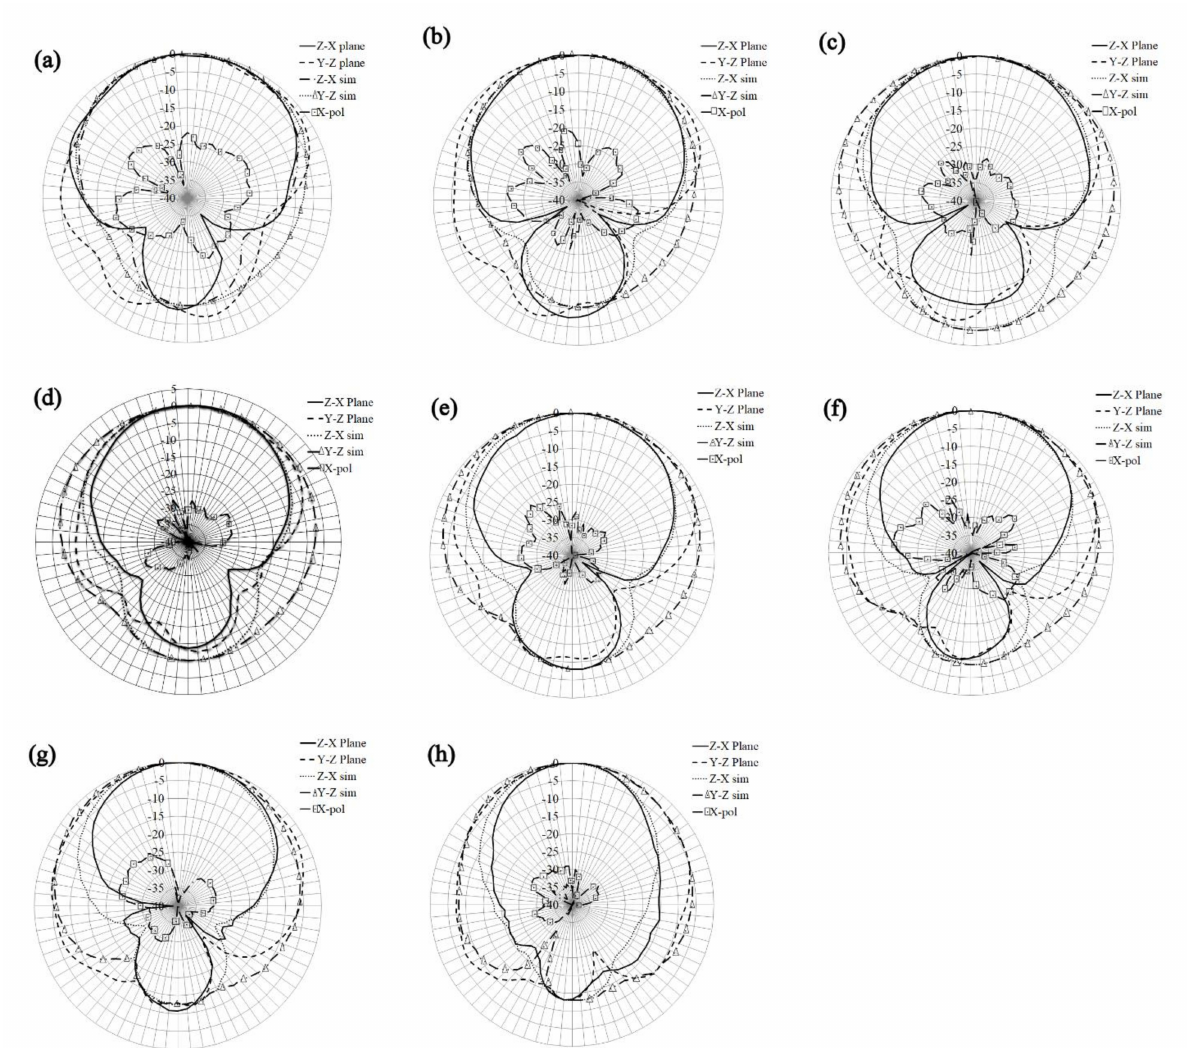
Figure 17. Measured gain patters at ( a ) 1.71 GHz, ( b ) 1.84 GHz, ( c ) 2 GHz, ( d ) 2.22 GHz, ( e ) 2.48GHz, ( f ) 2.81 GHz, ( g ) 3.33 GHz and ( h ) 4.92